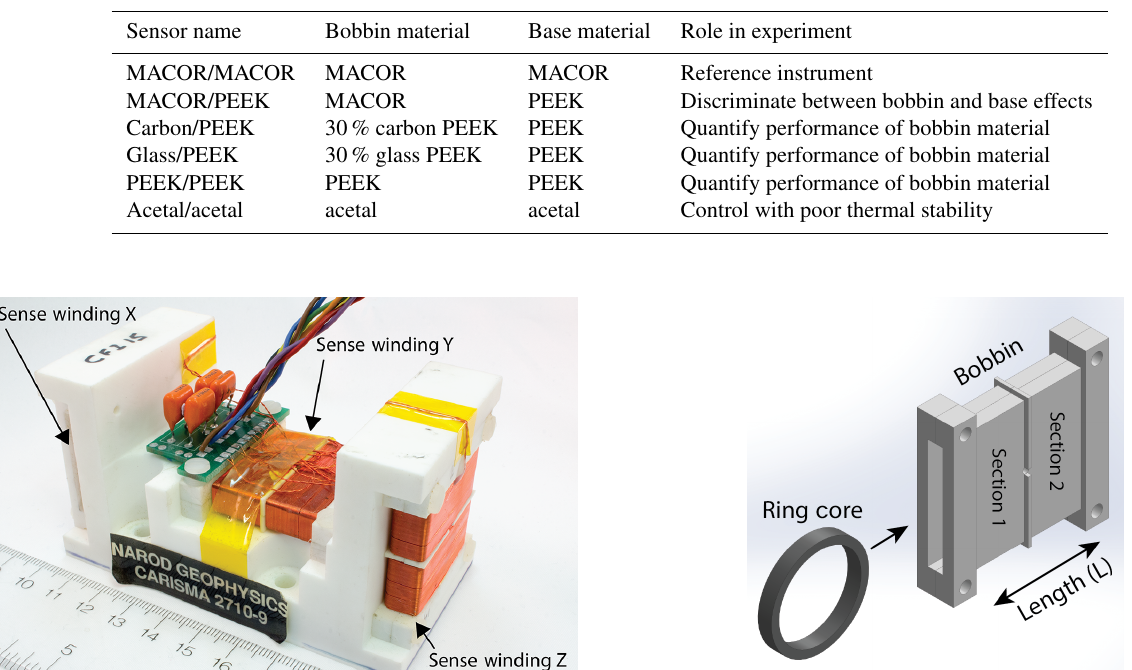
Figure 3. Modified transconductance amplifier providing temperature compensation to a single magnetometer channel. Table 2. Sensors used in this study and their makeup.